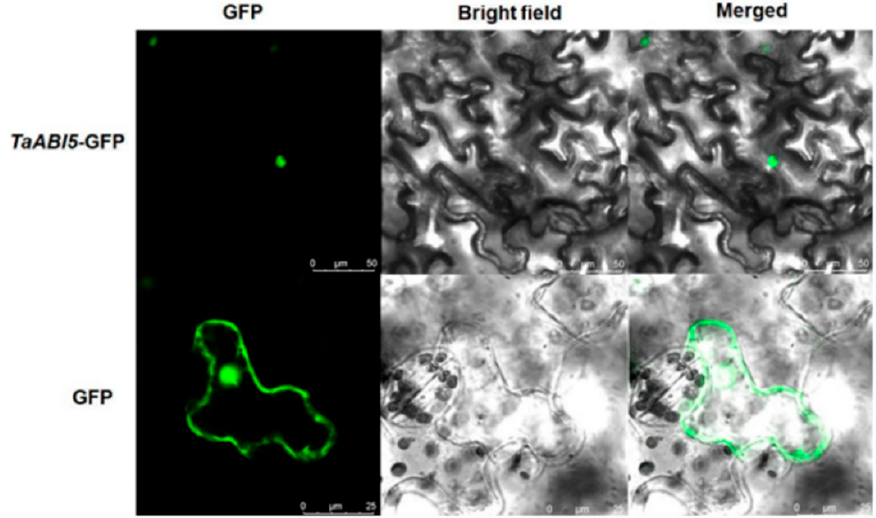
Figure 11. Fluorescence of TaABI5 in tobacco leaf cells. Subcellular localization of TaABI5 ( top ) and empty vector ( bottom ) in dark field, bright field, and merged field. Scale bars = 25 µm.